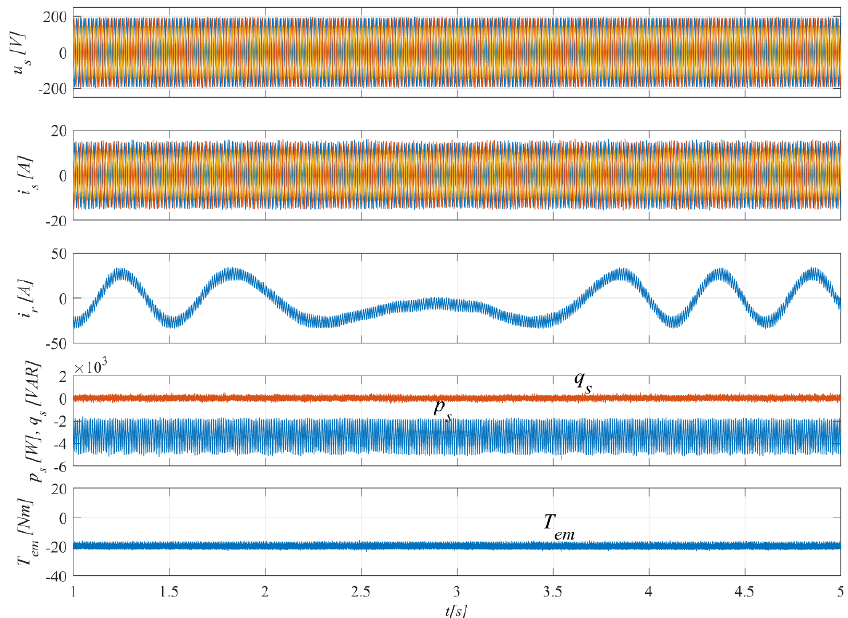
Figure 18. Experimental tests results of DPC during variable speed operation in case of asymmetrical grid voltage operation without the feedforward, decoupling mechanism and information about the rotor current value included in the control, Q sref = 0, T emref = − 19.5 Nm.